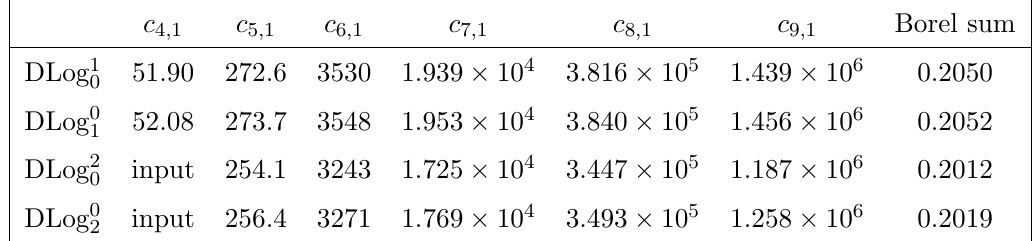
Table 5. QCD Adler function coe(cid:14)cients from D-Log Pad(cid:19)e approximants formed to B [ (cid:14) (0) ]( u ).